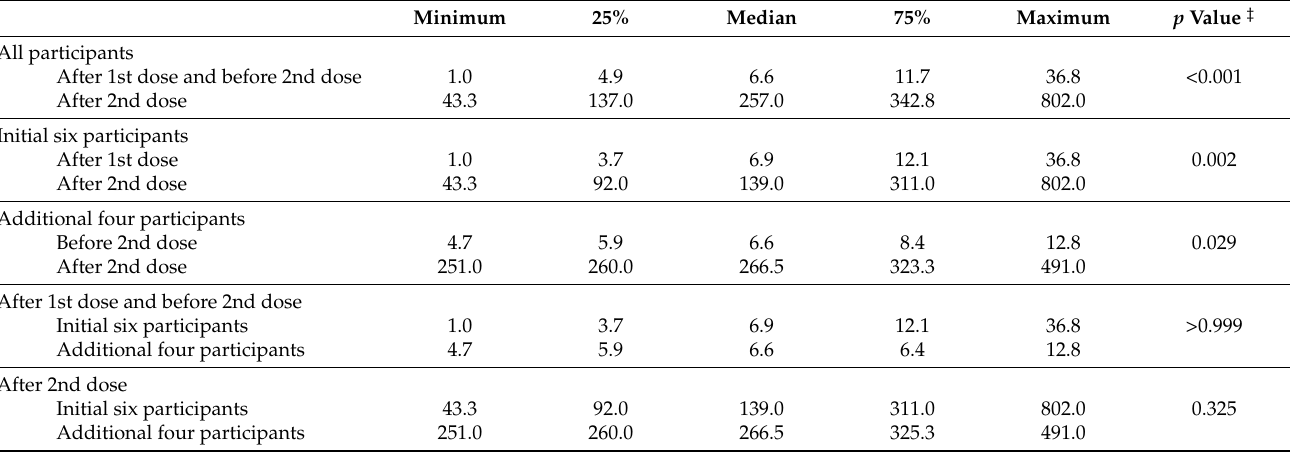
Table 3. Distribution of anti-spike protein immunoglobulin G titers (AU/mL) before and after the second dose of BNT162b2